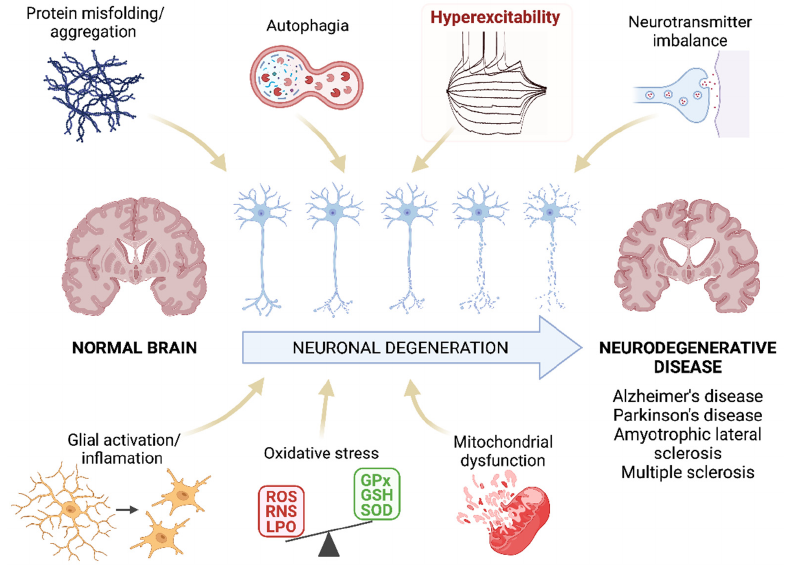
Figure 1. Pathogenesis of neurodegenerative diseases. Schematic representation of the mechanisms that are proposed as the main pathogenic agents of neurodegenerative diseases. We highlight the hyperexcitability as this parameter will be the main focus of this review. ROS: reactive oxygen spe- cies; RNS: reactive nitrogen species; LPO: lipid peroxidation; GPx: glutathione peroxidase; GSH: glutathione; SOD: superoxide dismutase. Created with BioRender.com [12].